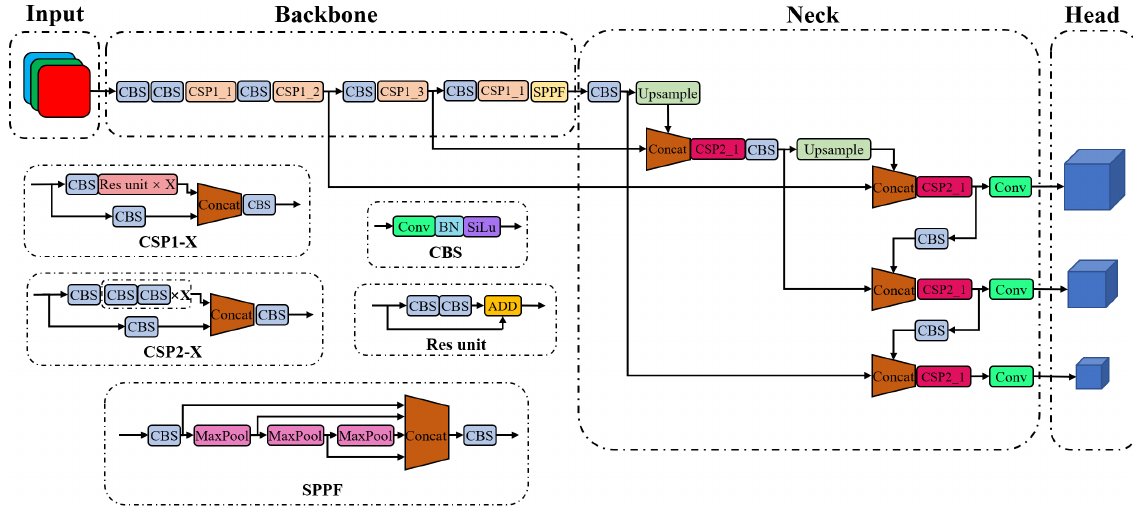
Figure 1. Original YOLOv5 network